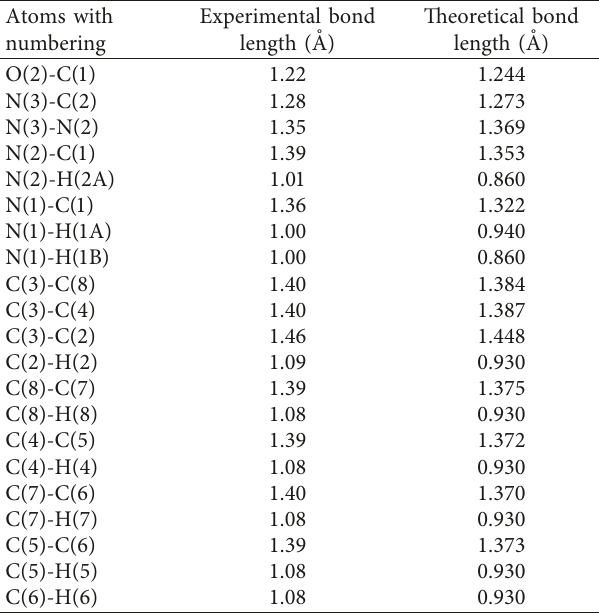
Table 1: Crystal data and structure refinement details of BDSC crystal.